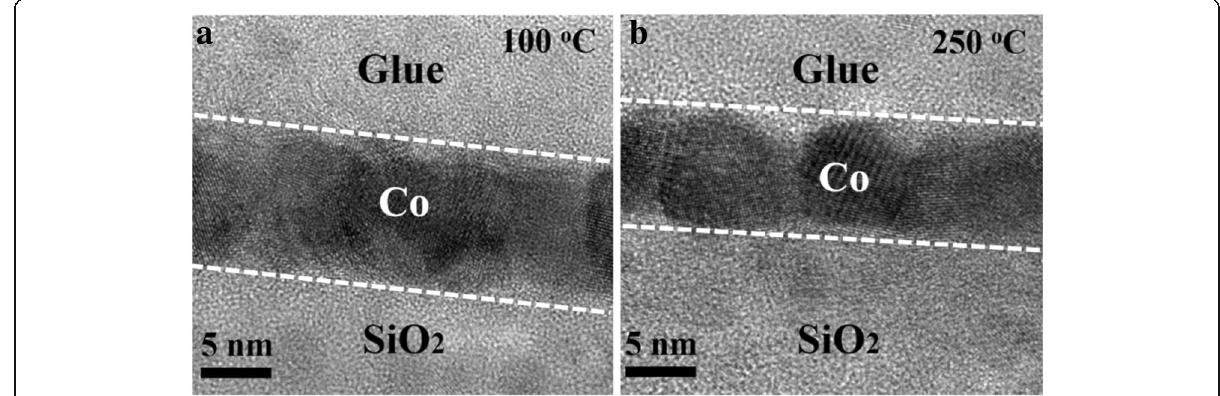
Fig. 4 The cross-sectional TEM images of the Co films (1200 cycles) deposited at a 100 °C and b 250 °C,